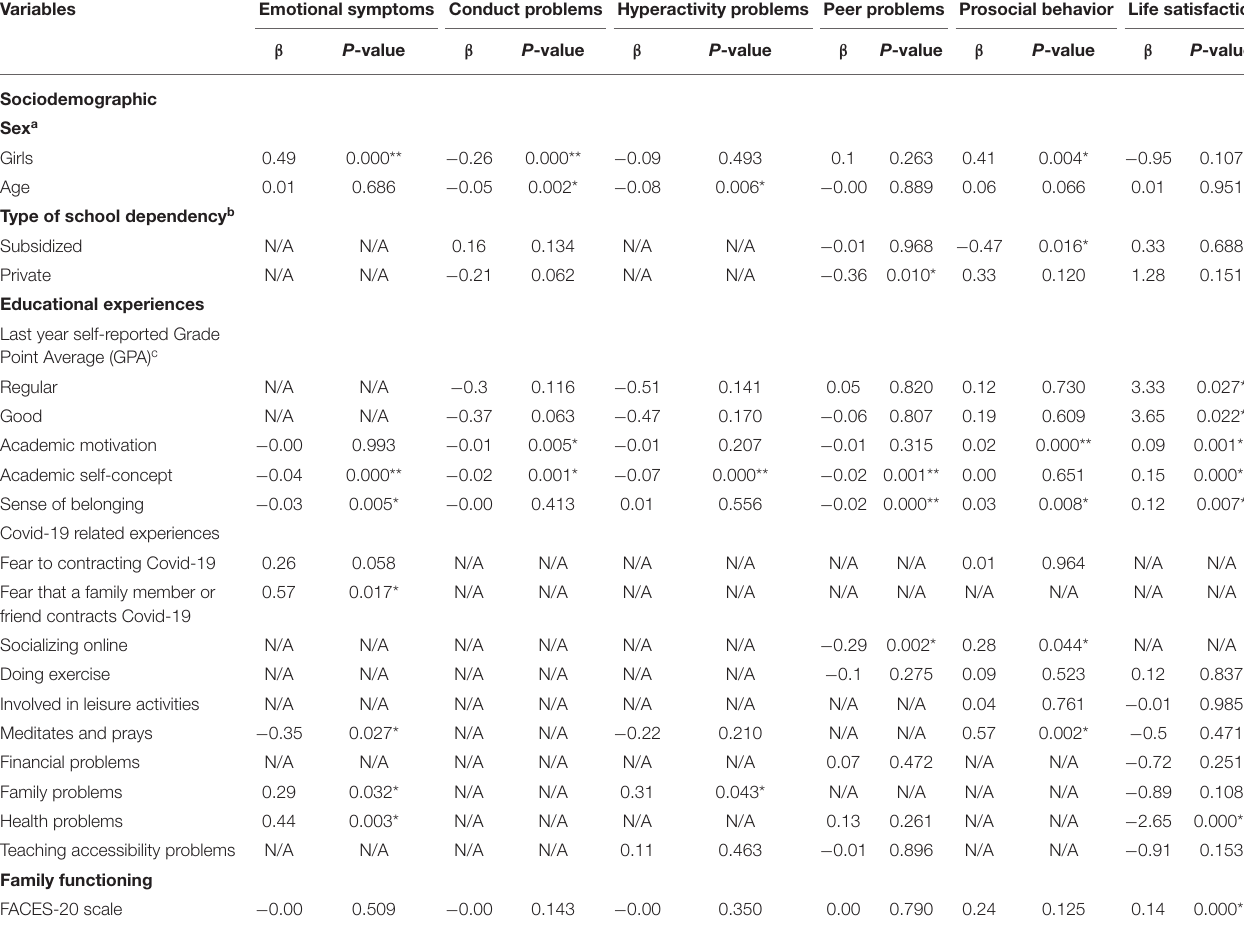
TABLE 3 | Adjusted regression models exploring the association between risk and protective factors and mental health problems and well-being among adolescents.